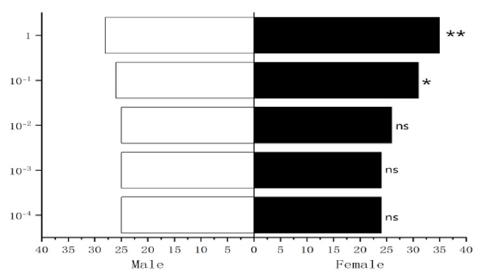
Figure 33. Comparison of behavioral responses of W. magnifica to methylheptenone.